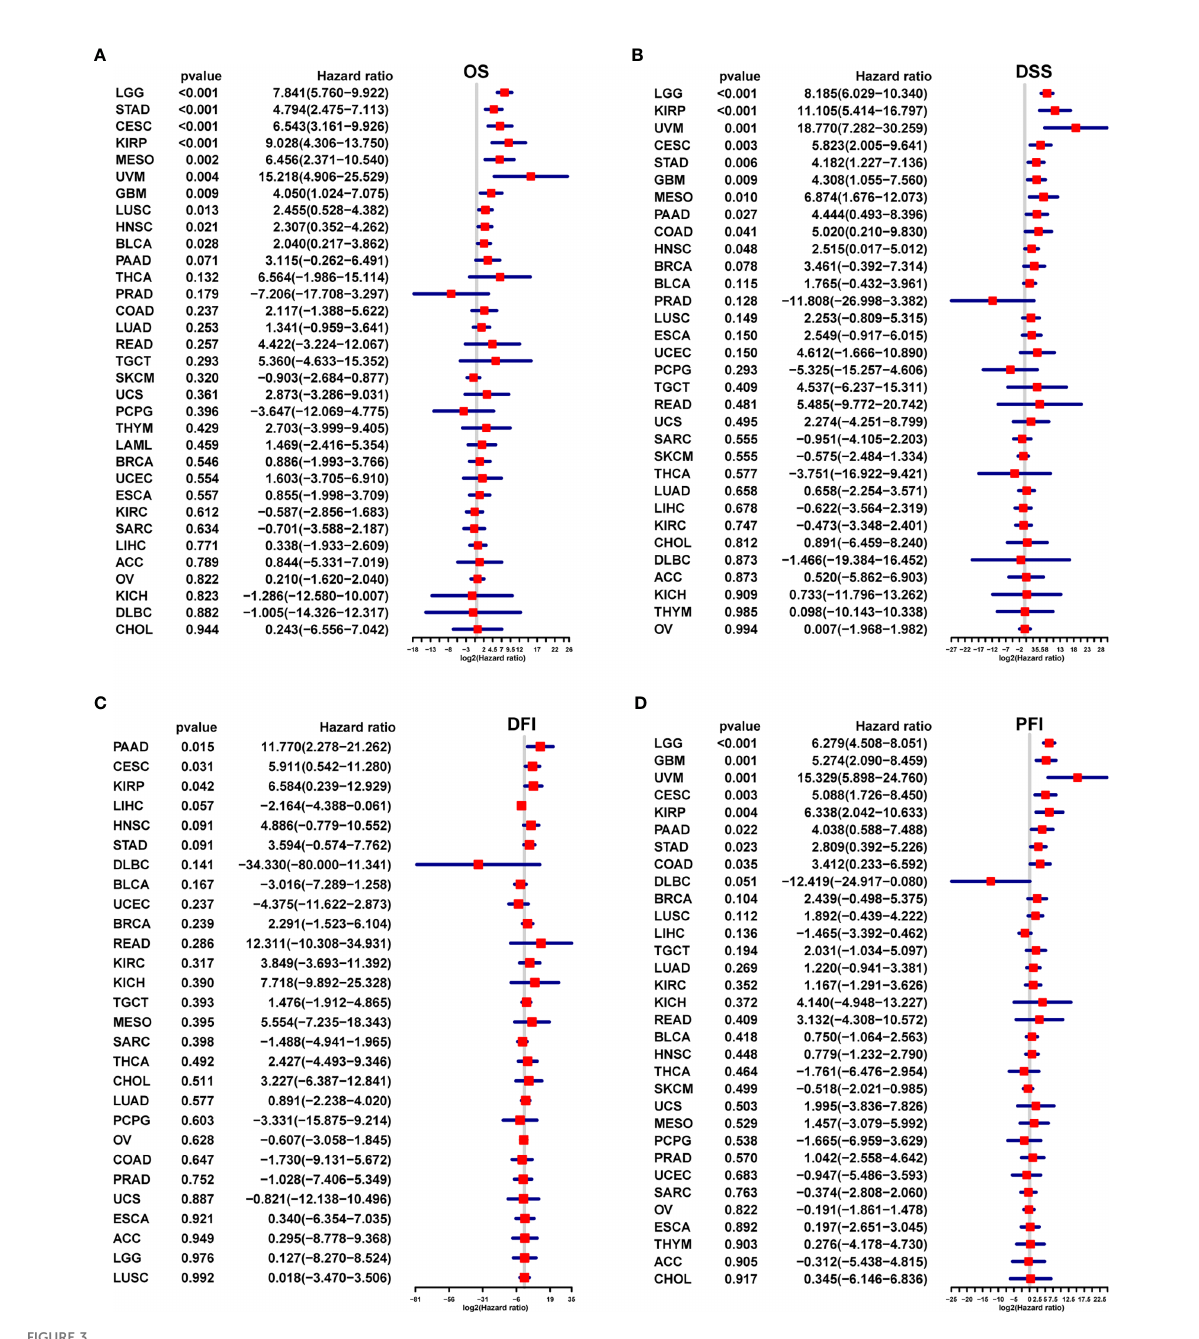
FIGURE 3 Survival prognostic analysis of the AR score. Univariate Cox regression analysis of the correlation between the AR score and (A) overall survival (OS), (B) disease speci fi c survival (DFS), (C) disease free interval (DFI) and (D) progression free interval (PFI) in different